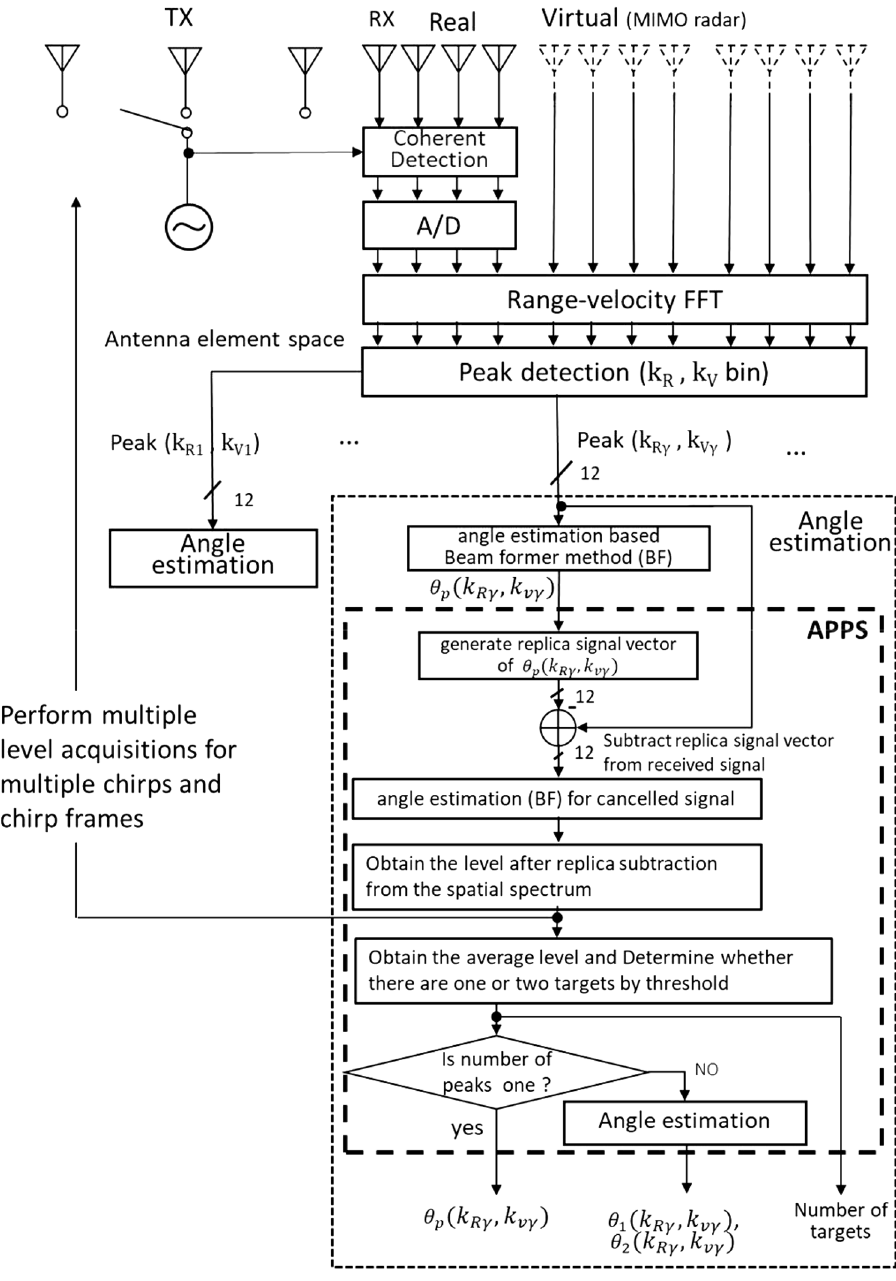
Figure 2. System structure of the proposed